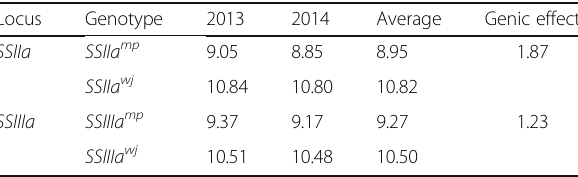
Table 4 Allelic effect on AC of SSIIa and SSIIIa genes for 64 semi-waxy lines in 2013 and 2014